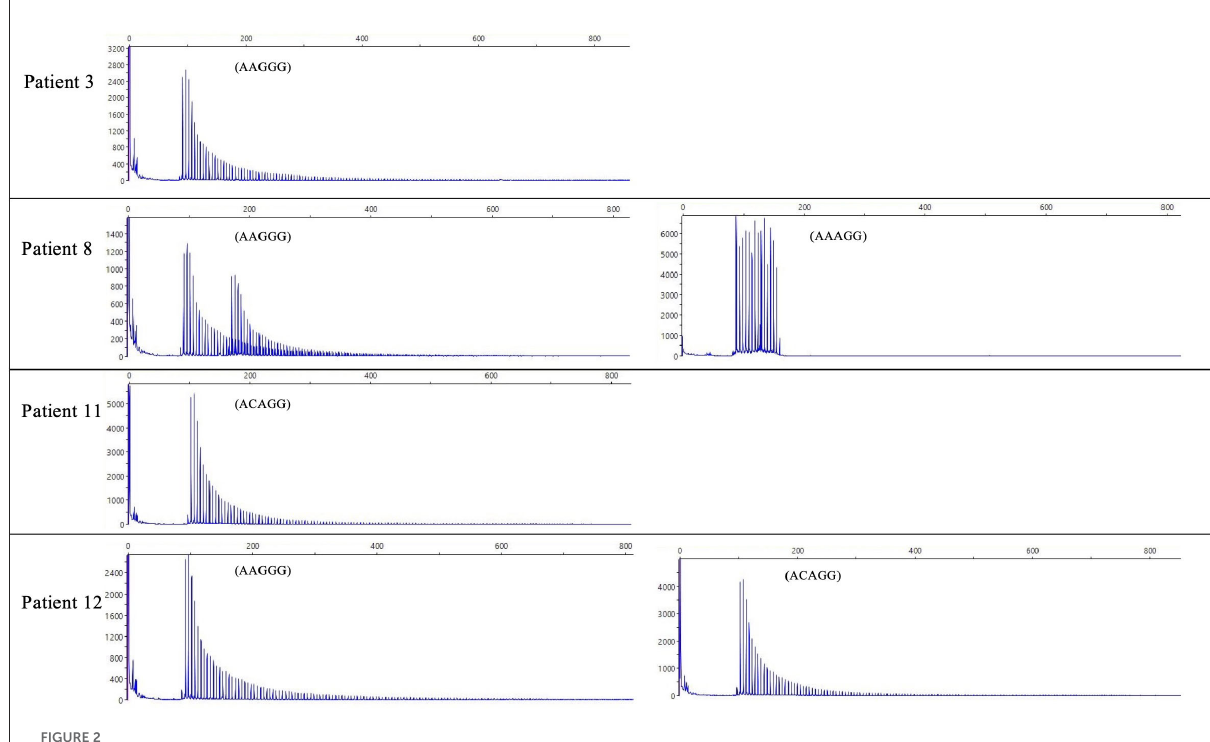
FIGURE2 The result of RP-PCR. Sawtooth patterns on Peak Scanner of RP-PCR products, including (AAGGG)exp/(AAGGG)exp (patient 3),